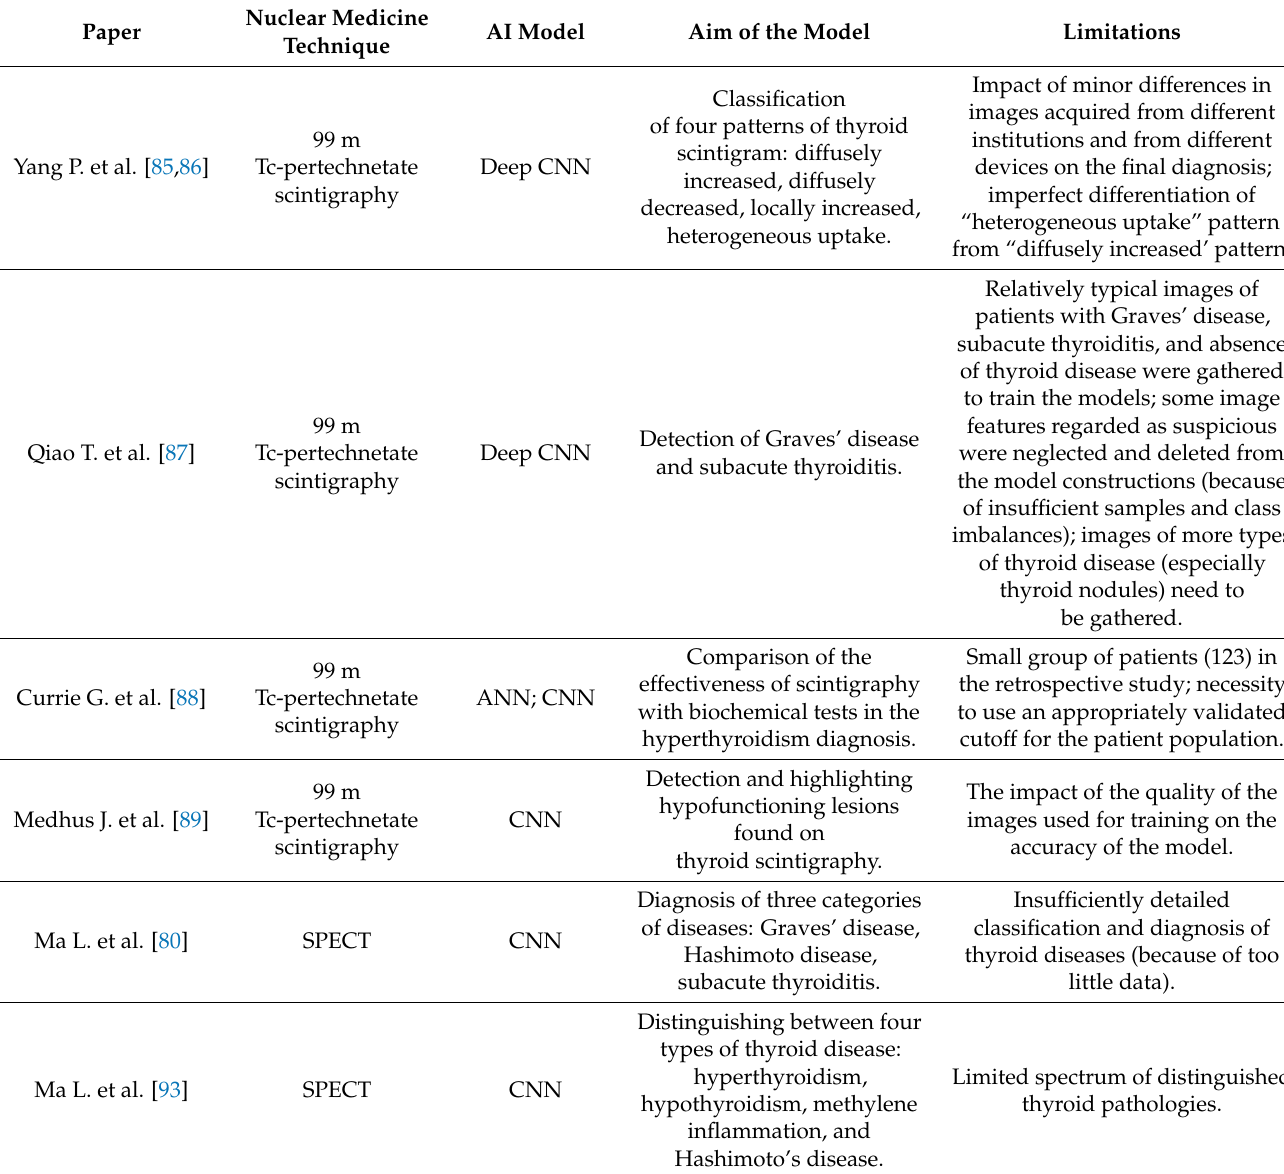
Table 4. A comparison of works that suggest the use of AI assisted nuclear medicine methods in the diagnosis of thyroid